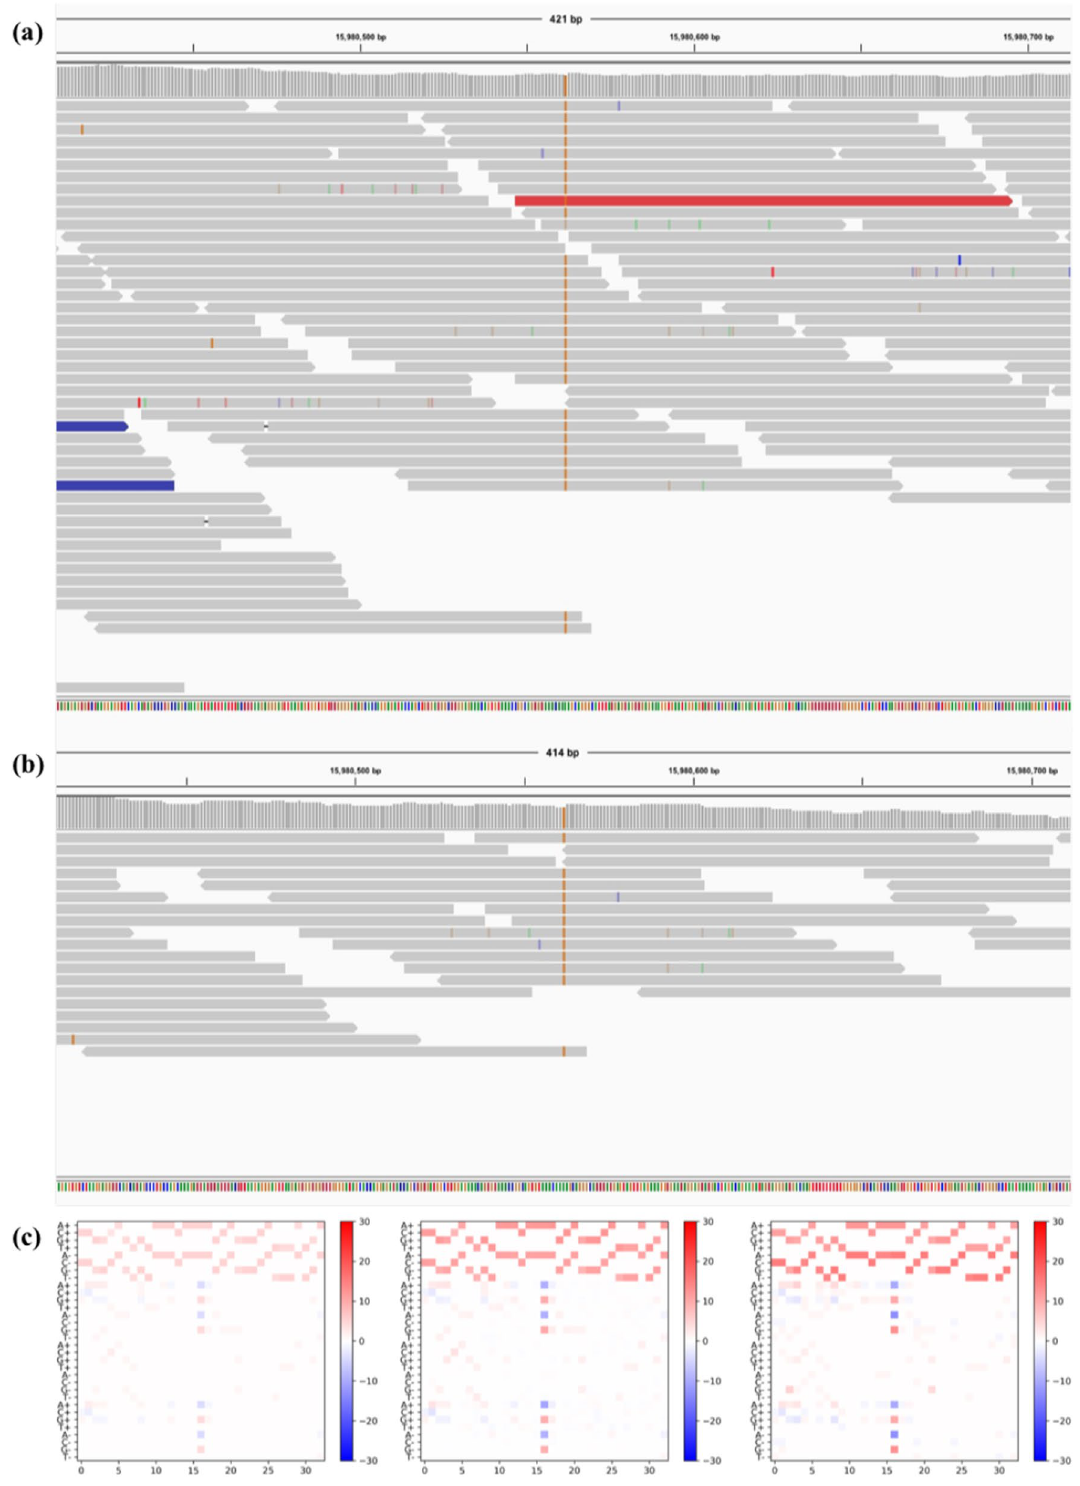
Figure 4. Example of IGV visualization. The variant is at chr21:15,980,562 of HG002. This variant is not detected by Clair method on 0.3ds down-sampled data. But our LDV-Caller correctly found it from 0.3ds data and gave a high confidence. ( a ) is the alignment of original high depth data. ( b ) is the alignment of 0.3ds down- sampled data. ( c ) contains three pileup images. From left to right, they are low depth pileup image, predicted “high” depth pileup image, and real high depth pileup image